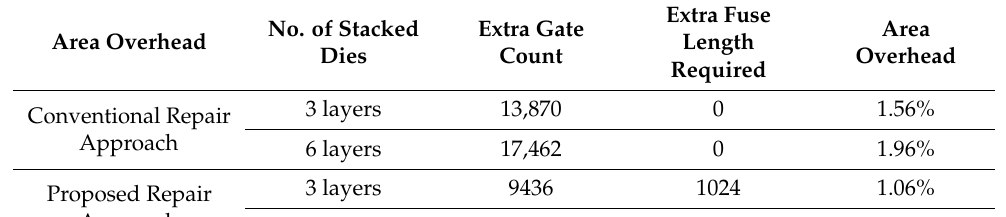
Table 3. Area Overhead comparison.